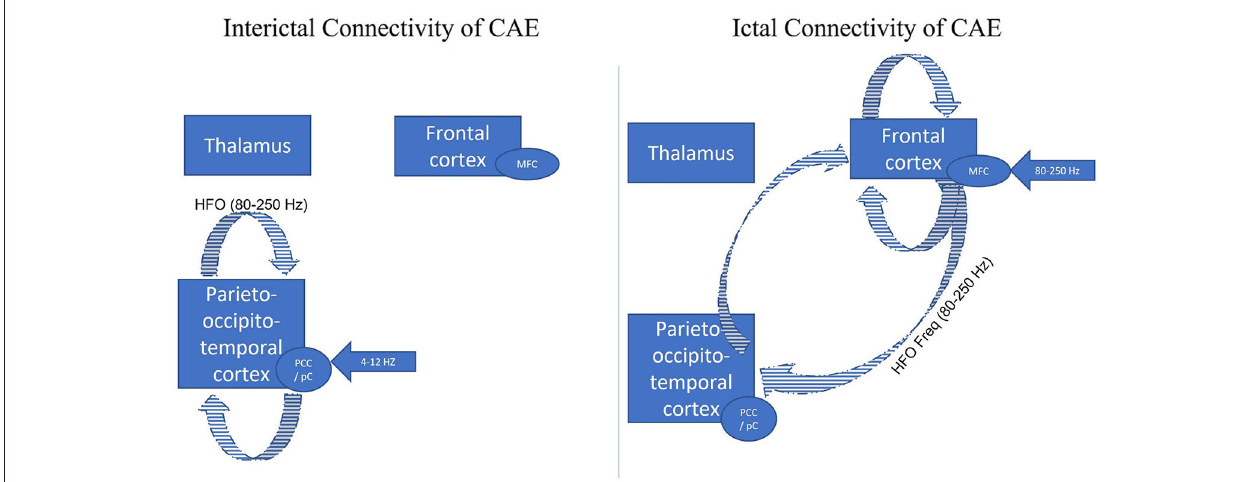
FIGURE 2 | Adapted with permission from Tenney et al. (47). Figure comparing the interictal (GSWDs < 4s) and ictal connectivity (GSWDs > 10 s) in CAE. The three major brain regions have been identified as responsible for the generalization of the childhood absence seizures (thalamus, frontal cortex, posterior cortex). Given all the data from Shi et al. ( 126) the low frequency (4–8Hz and 8–12Hz) magnetic sources were mainly localized within the posterior cingulate cortex and precuneus (PCC/pC) during the interictal state (blue arrow). The high frequency (80–250Hz) magnetic components of the ictal GSWDs were mainly localized in the medial frontal cortex (blue arrow). In terms of connectivity (using posterior cingulate and precuneus (PCC/pC) as the seed), there were strong connections in the anterior-posterior pathway, mainly the frontal cortex during the ictal GSWDs (blue stripped). In contrast, the connections were mostly limited to the posterior cortex region at 80–250Hz during interictal GSWDs (blue stripped). Thus, there were significant disparities in the source localization between ictal and interictal GSWDs.